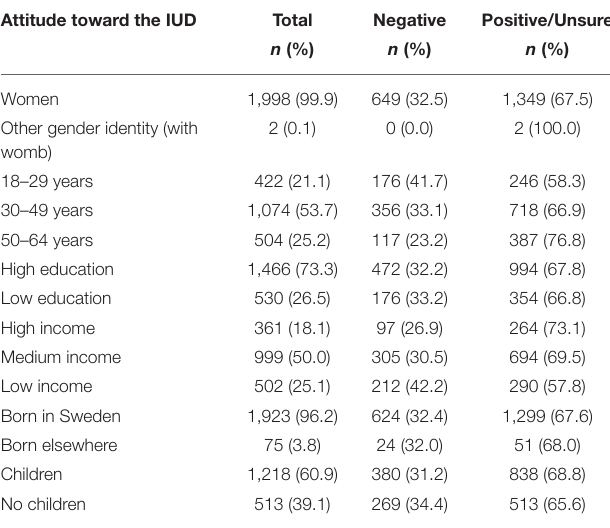
TABLE 1 | Unweighted study population characteristics and distribution of negative attitudes toward the copper IUD between sociodemographic groups. Attitude toward the